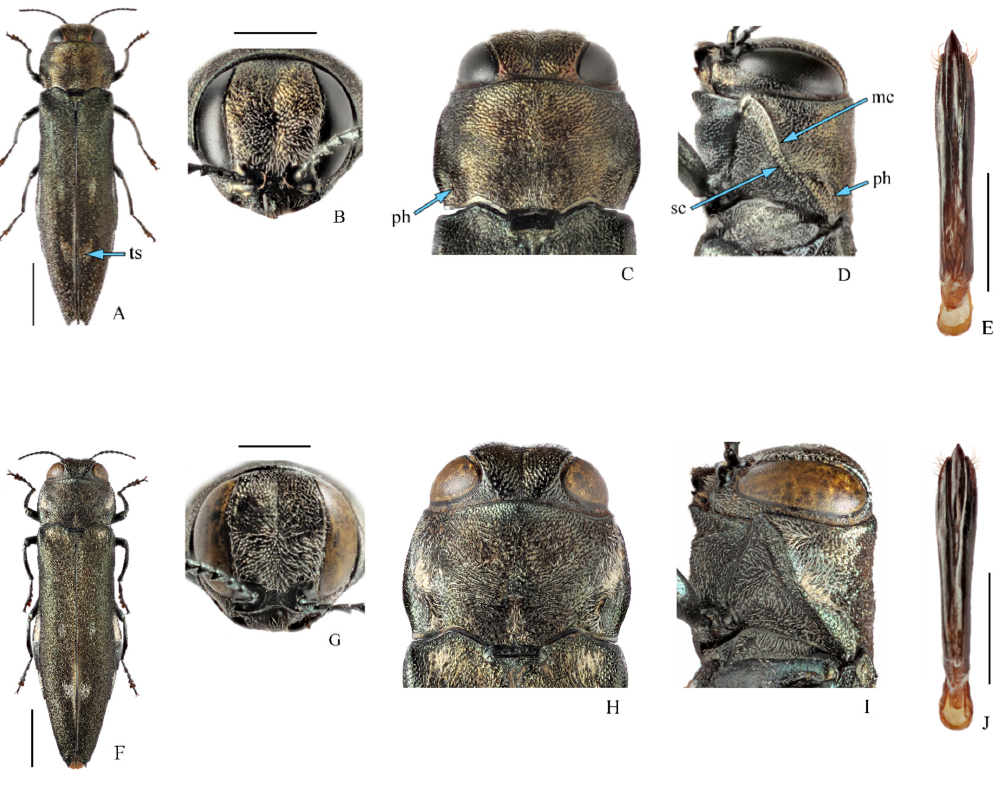
Figure 3A–E and Figure 4; Table 2.